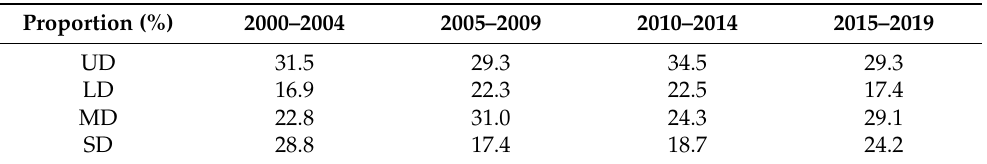
Table 2. Proportion of grassland distribution area with different degradation degrees in the study area, from 2000 to 2019.